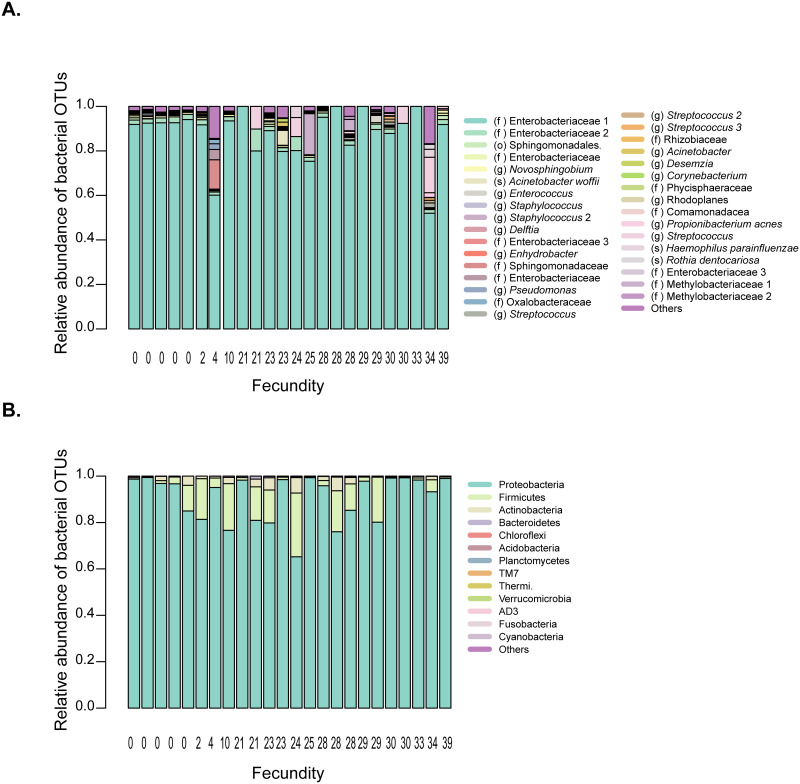
Females with varying fecundity have similar microbial communities.Stacked bar plots show the average relative abundance of the 5 most abundant bacterial OTUs, (A) classified to the lowest possible taxonomic level (o = order, f = family, g = genus, s = species). Numbers after each name distinguish OTUs with the same taxonomic classification (with 97% sequence identity). (B) Phylum level.